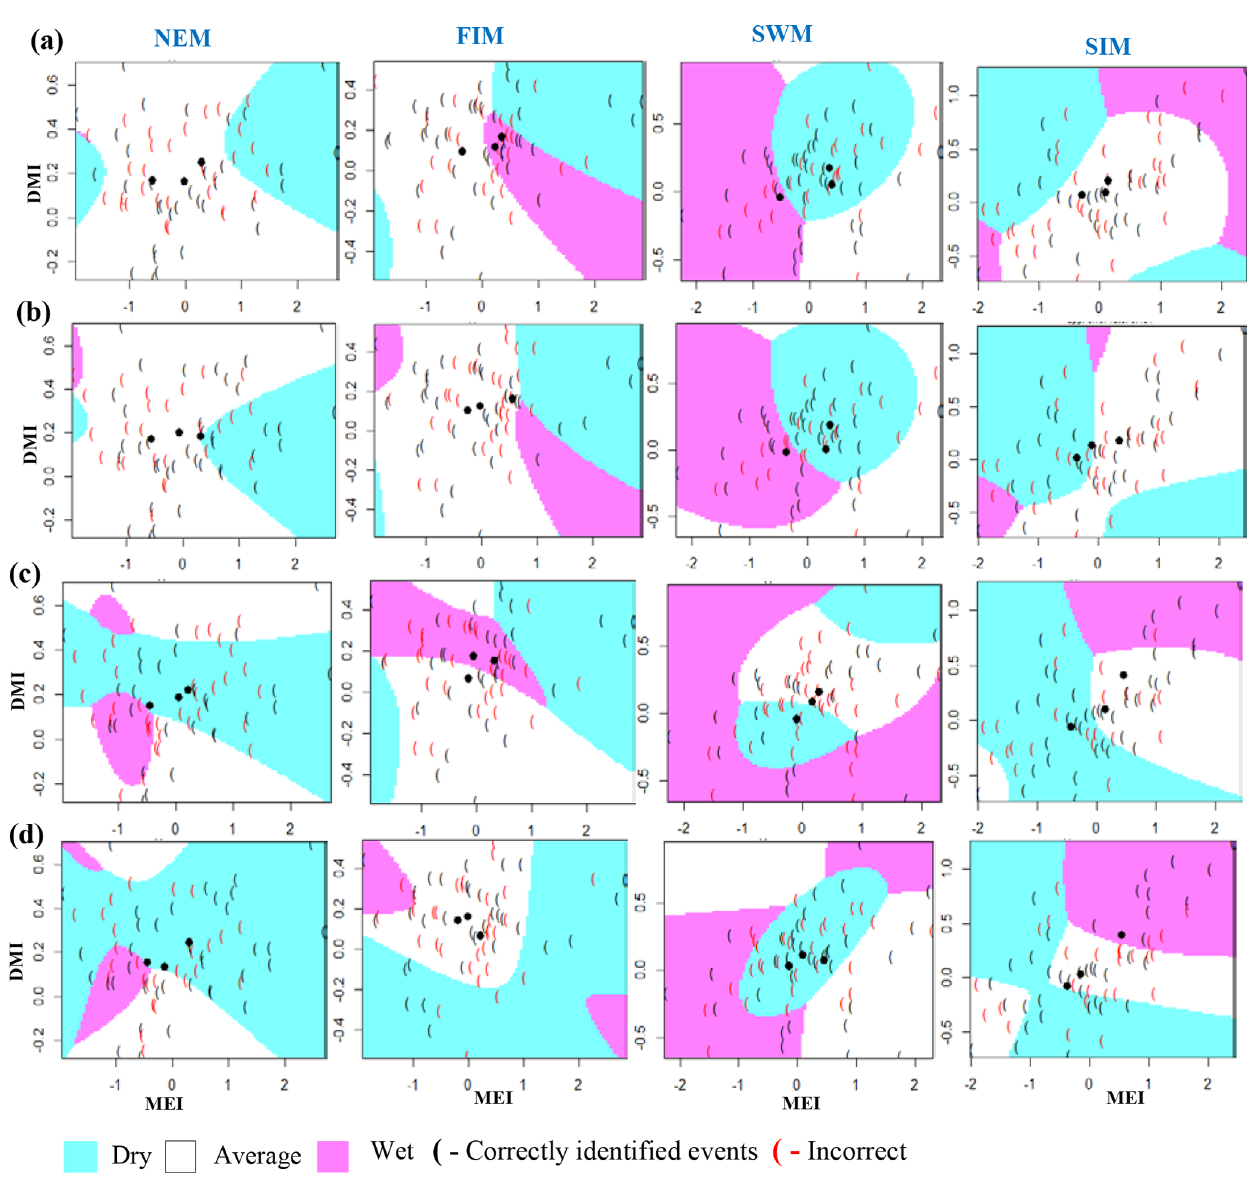
Figure A6. Identifying relationships between three rainfall cases (dry, average, wet) and MEI and DMI values using QDA models. (a) Morape, (b) Peradeniya, (c) Randenigala, and (d)